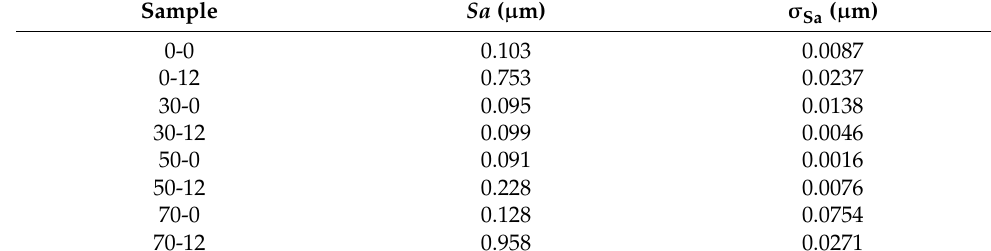
Table 5. Surface roughness Sa of the studied materials upon incubation. The standard deviation σ Sa is listed as well.